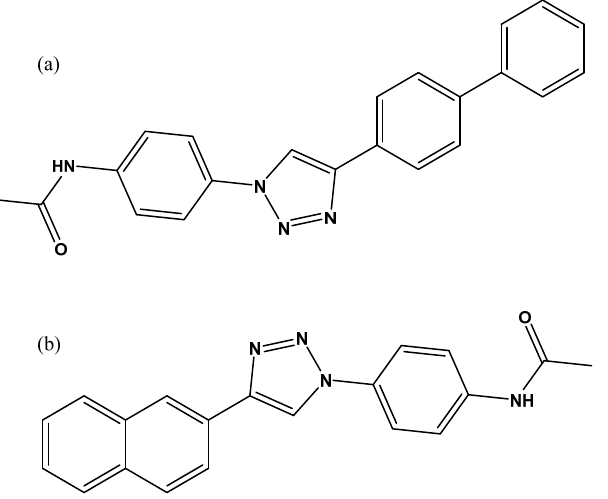
Figure 18. Structure of hits found by the tethering in situ chemistry technique ( a ) APBT; ( b ) APNT.